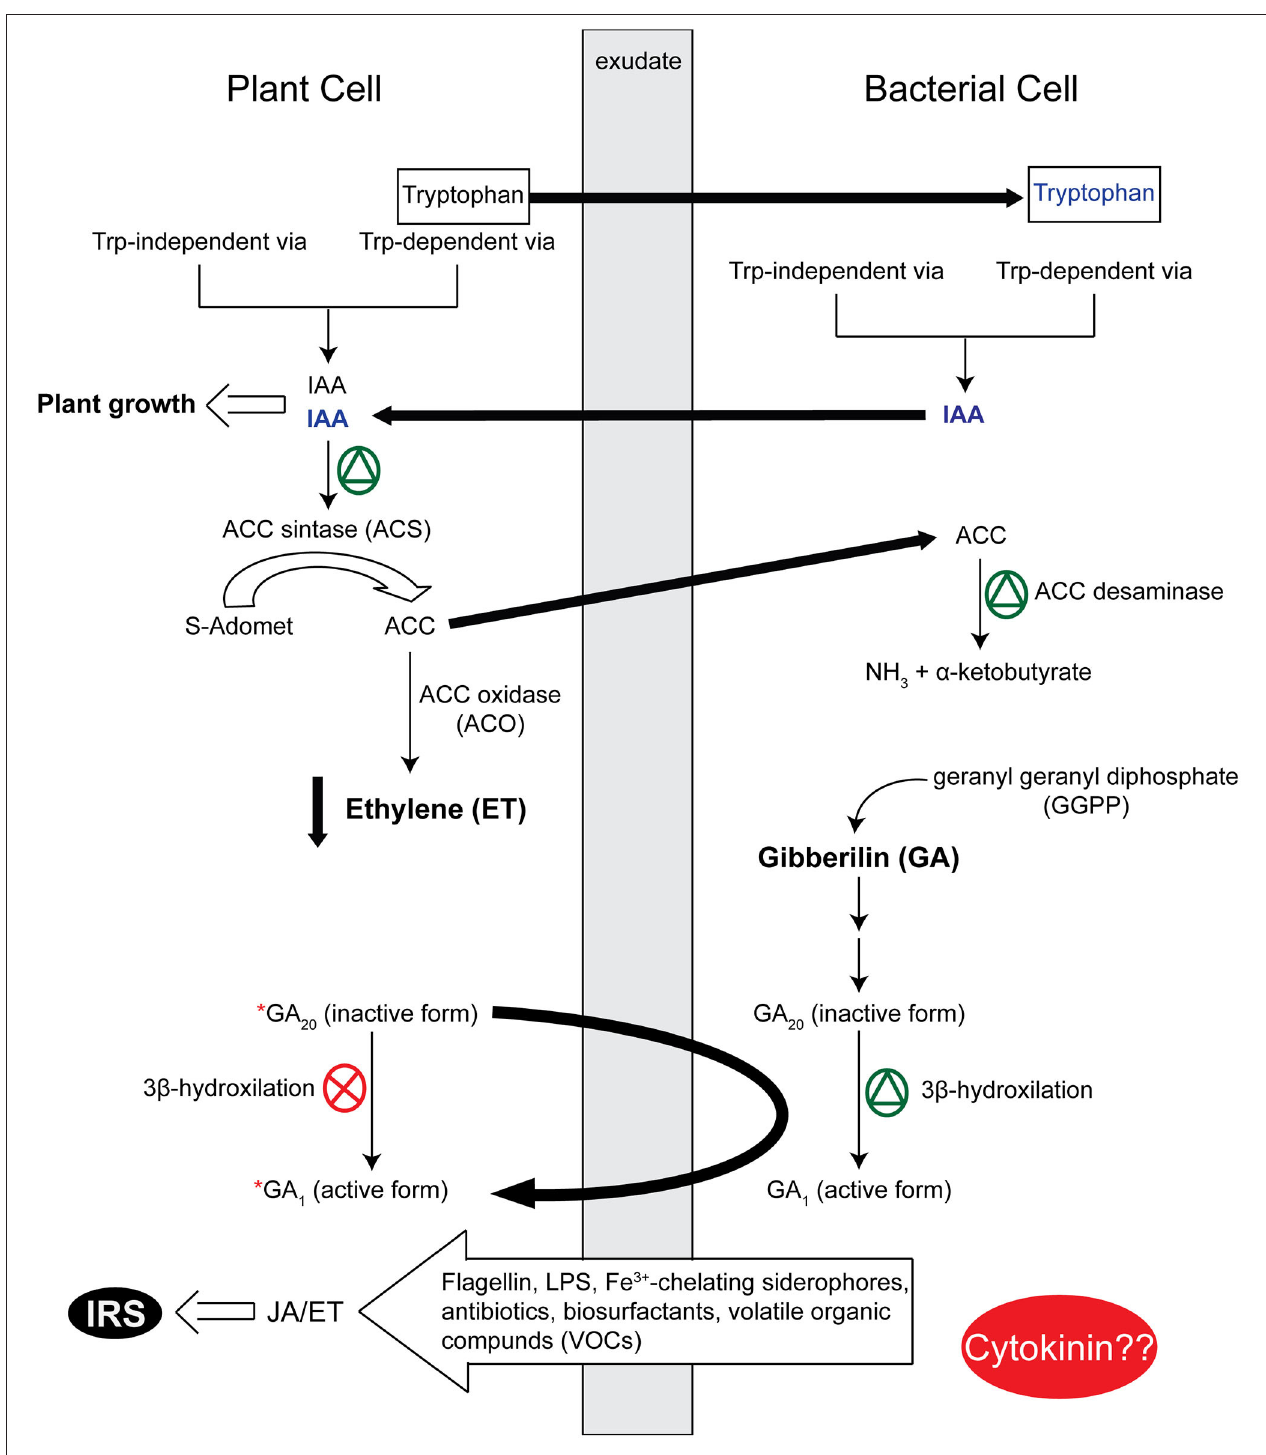
FIGURE 2 | A schematic representation of phytohormone modulation by plant-bacteria interactions. Indol-3-acetic acid (IAA) produced by bacteria and plants through tryptophan-dependent or/and tryptophan-independent pathways activates ACC synthase in plants. ACC synthase stimulates ACC production; ACC is hydrolyzed by bacterial ACC deaminase in NH 3 and α -ketobutyrate, decreasing ethylene levels in plants (Glick et al., 1998; Glick, 2012). After inoculation with the Azospirillum lipoferum strain USA5b in mutant rice plants that present genetic lesions in the 3 β -hydroxylation step in gibberillin synthesis, the active form of gibberillin (GA 1 ) was detected, which indicates active gibberillin synthesis in bacteria (Cassán, F., et al., 2001; Cassán et al., 2001). The response to jasmonic acid (JA), its derivatives and ethylene is necessary for induced systemic resistance (IRS), and different bacterial determinants are responsible for initiating priming in these hormones. Little information is available on bacterial cytokinin role in plant-bacteria interactions. activation;